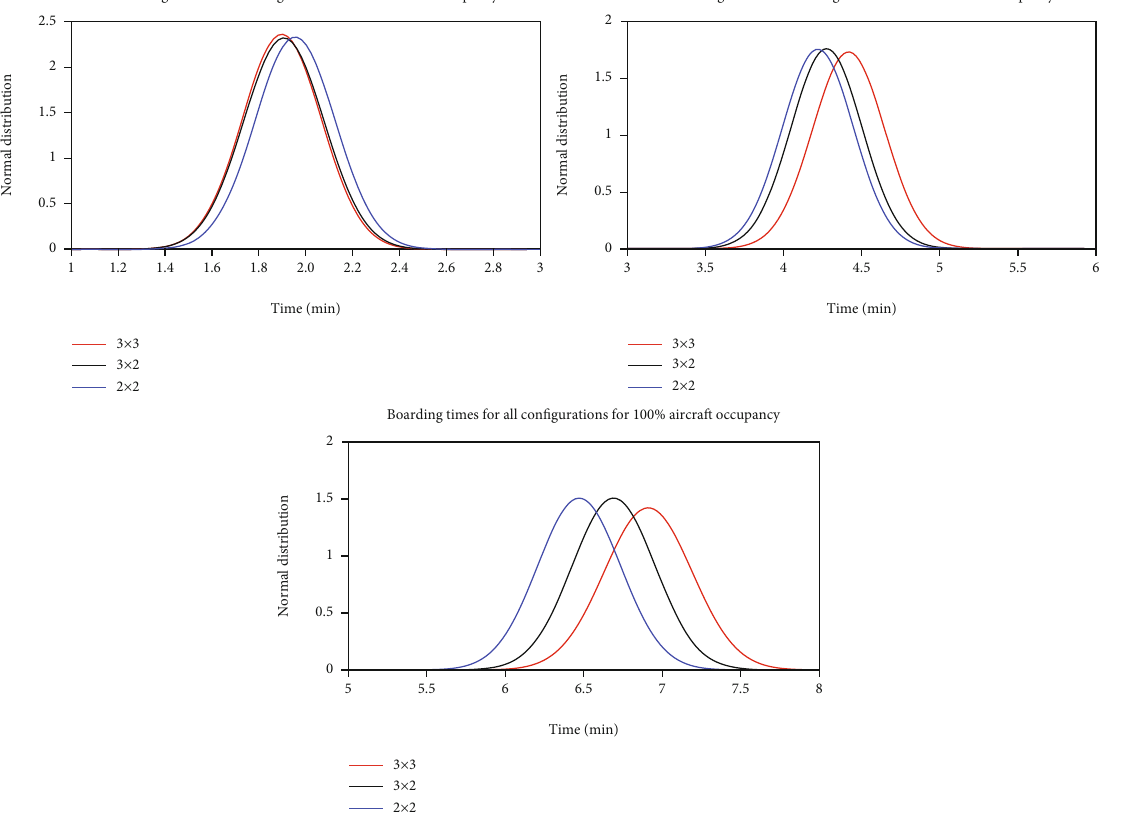
Figure 8: Fitted normal distribution curves for each aircraft con fi guration using the random outside-in boarding strategy for di ff erent % of aircraft